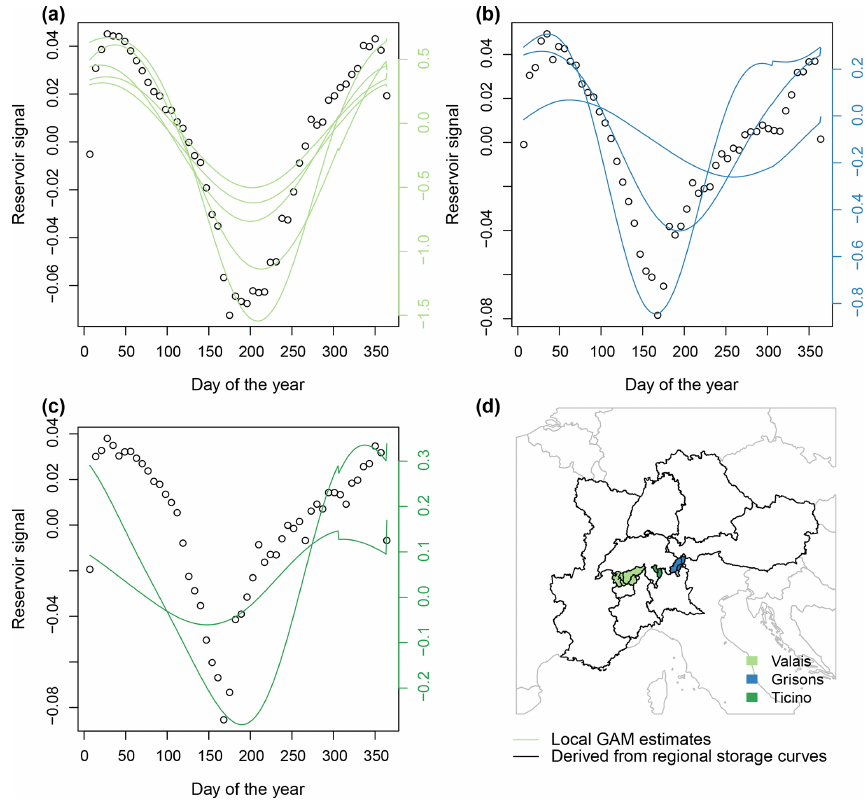
Figure 7. Regional reservoir storage change curves for the regions (a) Valais, (b) Grisons, and (c) Ticino derived from regional reservoir storage data provided by the Swiss Federal Office of Energy compared to the reservoir regulation signals estimated using the GAM of the catchments located in the corresponding cantons (d) . (a) Rhône, Porte-du-Scex, Rhône, Sion, Rhône, Branson, Dranse de Bagnes, Le Châble, and Vispa, Visp. (b) Inn, Tarasp, Inn, Martina, and Spöl, Punt dal Gall. (c) Brenno, Loderio and Moesa,